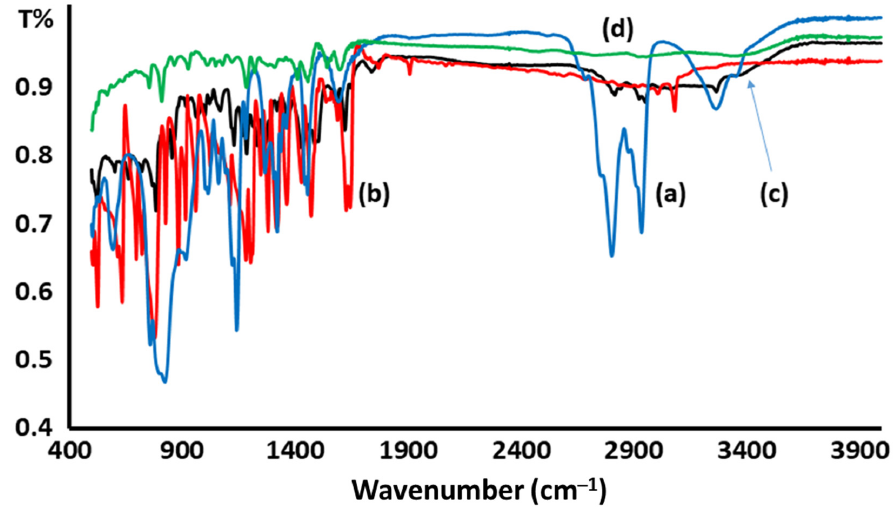
Figure 2. FT-IR of 2-(1-piperazinyl)ethylamine ( a ), 5-fluoro-2-hydroxyacetophenone ( b ), ligand ( c ), complex 1 ( d ).